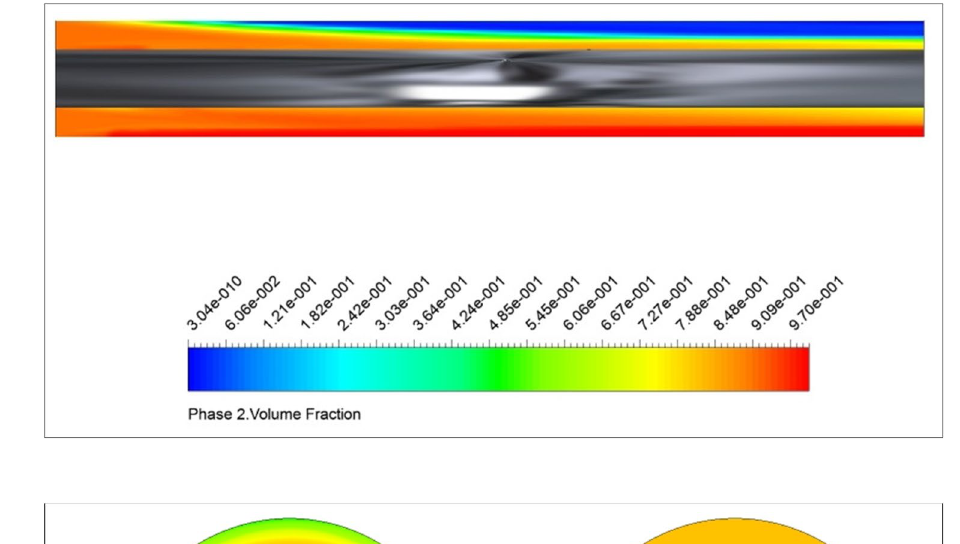
Fig. 14 Cuttings volume frac- tion along a longitudinal cross section of the annulus in terms of distance from the input sec- tion: a 0 ″ , b 12 ″ , c 24 ″ , d 36 ″ , e 48 ″ , f 60 ″ , g 72, h 48 ″ , i 96 ″ , j 108 ″ , k 120 ″